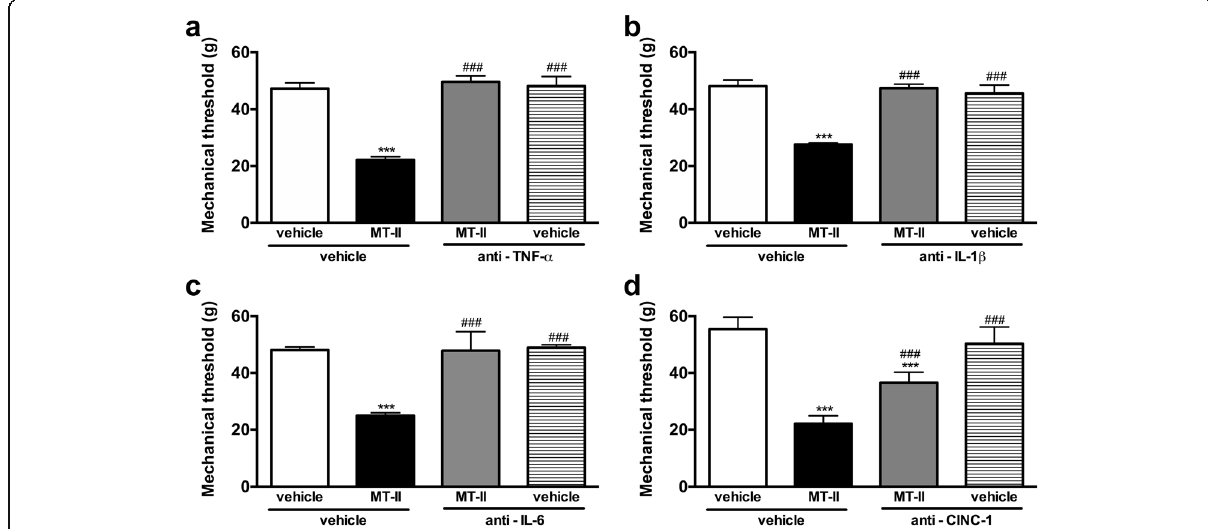
(25 μ L). Pain threshold was determined using a modified electronic pressure-meter test 8 h after MT-II injection, and represented as force (in g ).